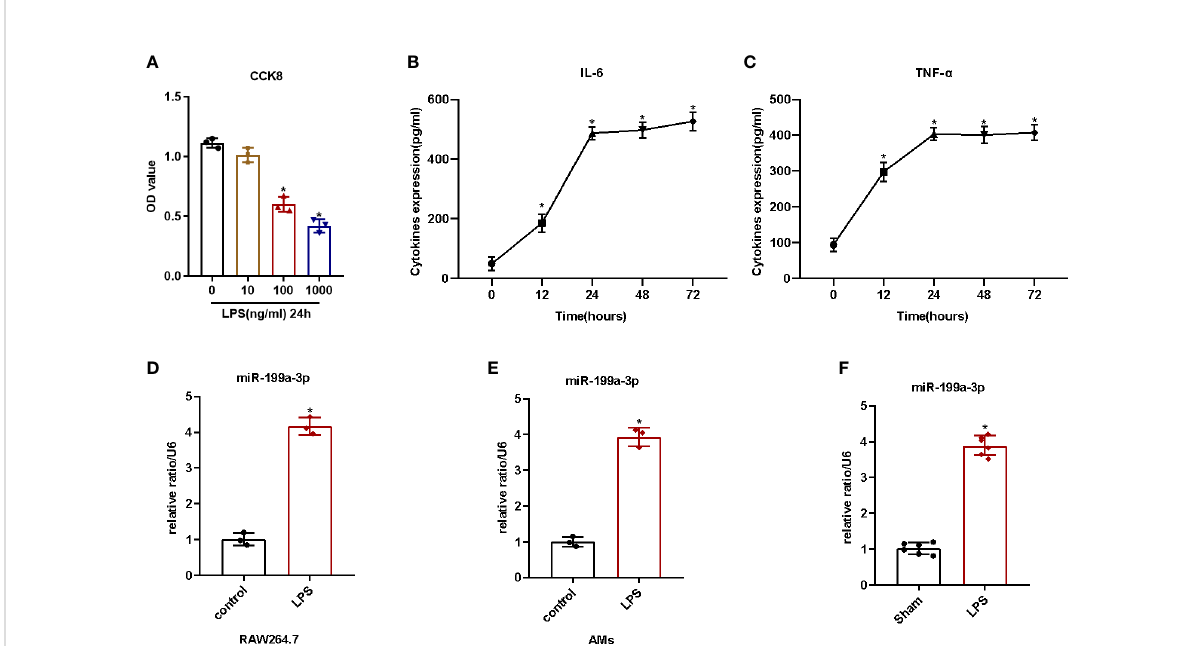
FIGURE 1 LPS-stimulated in fl ammatory reaction and MiR-199a-3p expression in vivo and in vitro . RAW264.7 cells were stimulated with or without LPS for 12, 24, 48, and 72 h. (A) The effects of various concentrations of LPS on the viability of RAW264.7 cells after 24 h treatment, as tested via CCK-8 assay (n = 3). (B) The effect of LPS (100 ng/ml) on the level of IL-6 in cell supernatants, as tested via ELISA (n = 3). (C) The effect of LPS (100 ng/ml) on the level of TNF- a in cell supernatants, as tested via ELISA (n = 3). (D) qRT-PCR detection of MiR-199a-3p expression in RAW264.7 cells after LPS treatment (n = 3). (E) qRT-PCR detection of MiR-199a-3p expression in alveolar macrophages after LPS treatment (n = 3). (F) MiR-199a-3p expression in BALF of LPS-induced ARDS or control mice was detected by qRT-PCR (n = 6). The experiments were repeated at least three times. Each value represents the mean ± SD of three independent experiments. *p < 0.05 vs . control group, Student ’ s t -test, or one-way